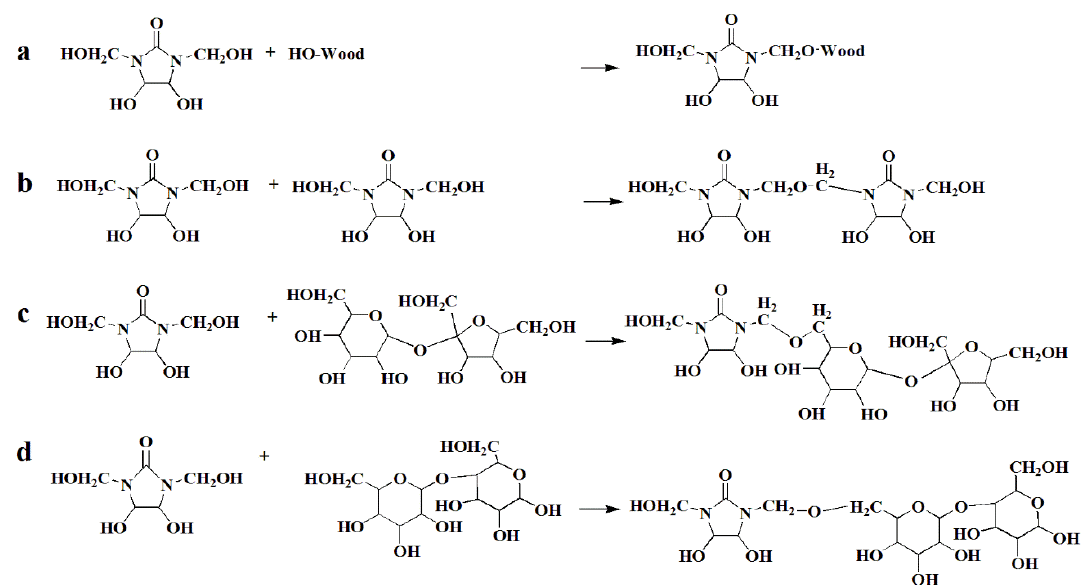
Figure 1. Reaction of DM with wood hydroxyl ( a ) and its own condensation ( b ) and reaction of DM with SU ( c ) and MA monomers ( d ).